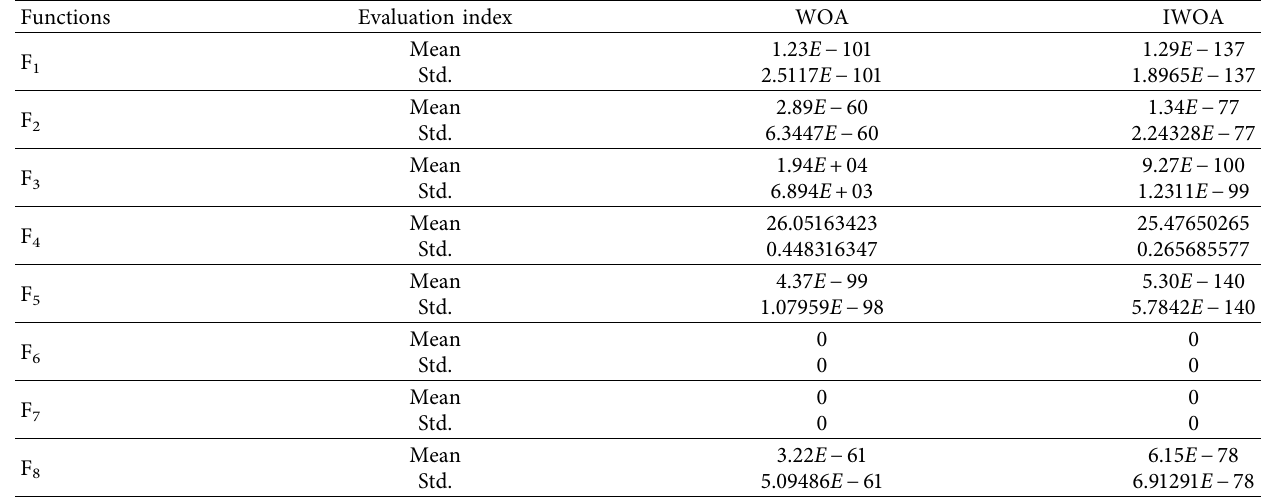
Table 2: Performance comparison with standard